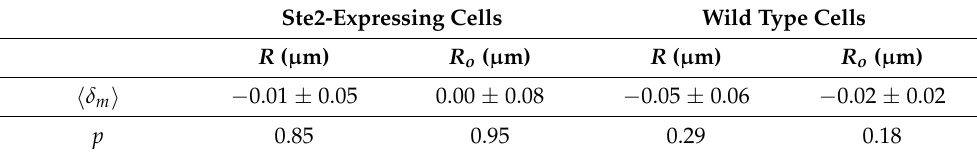
Table 4. Average difference in cellular and vacuolar radii plus or minus one standard deviation (n = 3 experiments) along with the p -value obtained by applying a paired Student’s t -test to pairs of for Ste2-expressing and Ste2 ∆ cells suspended in electrolytic solution with and without α -factor added to them. Ste2-Expressing